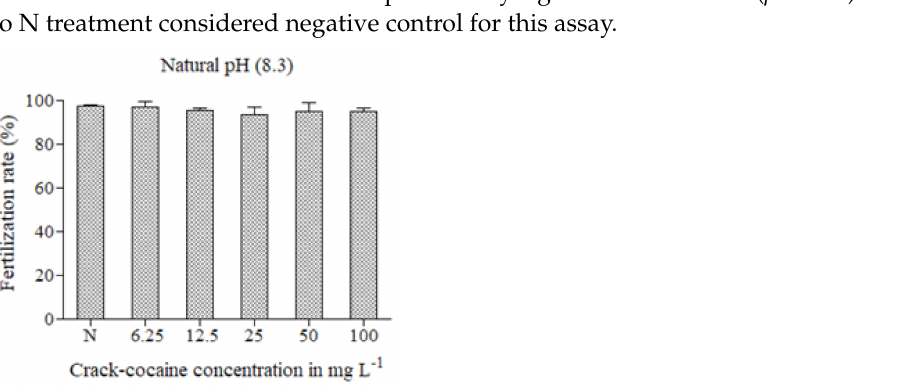
Figure 2. Perna perna fertilization rate (in %) results obtained after exposure to different concentrations of CC (6.25, 12.5, 25, 50, and 100 mg L − 1 ) without acidification at pH 8.3 considered the negative control. (N represents natural pH 8.3, with no acidification method applied).